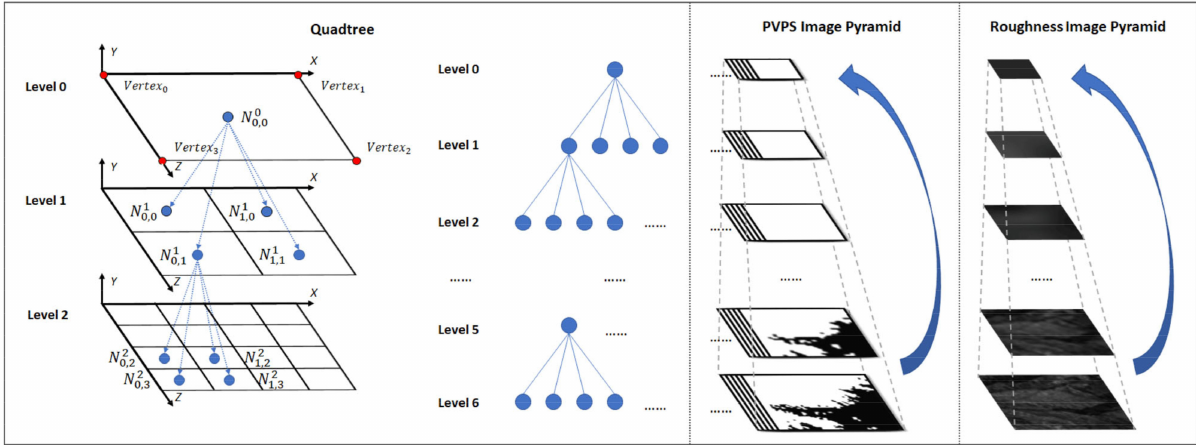
Figure 10. Diagram of the quadtree, PVPS Image Pyramid, and Roughness Image Pyramid. Blue circles represent quadtree nodes, and red circles represents corners of a